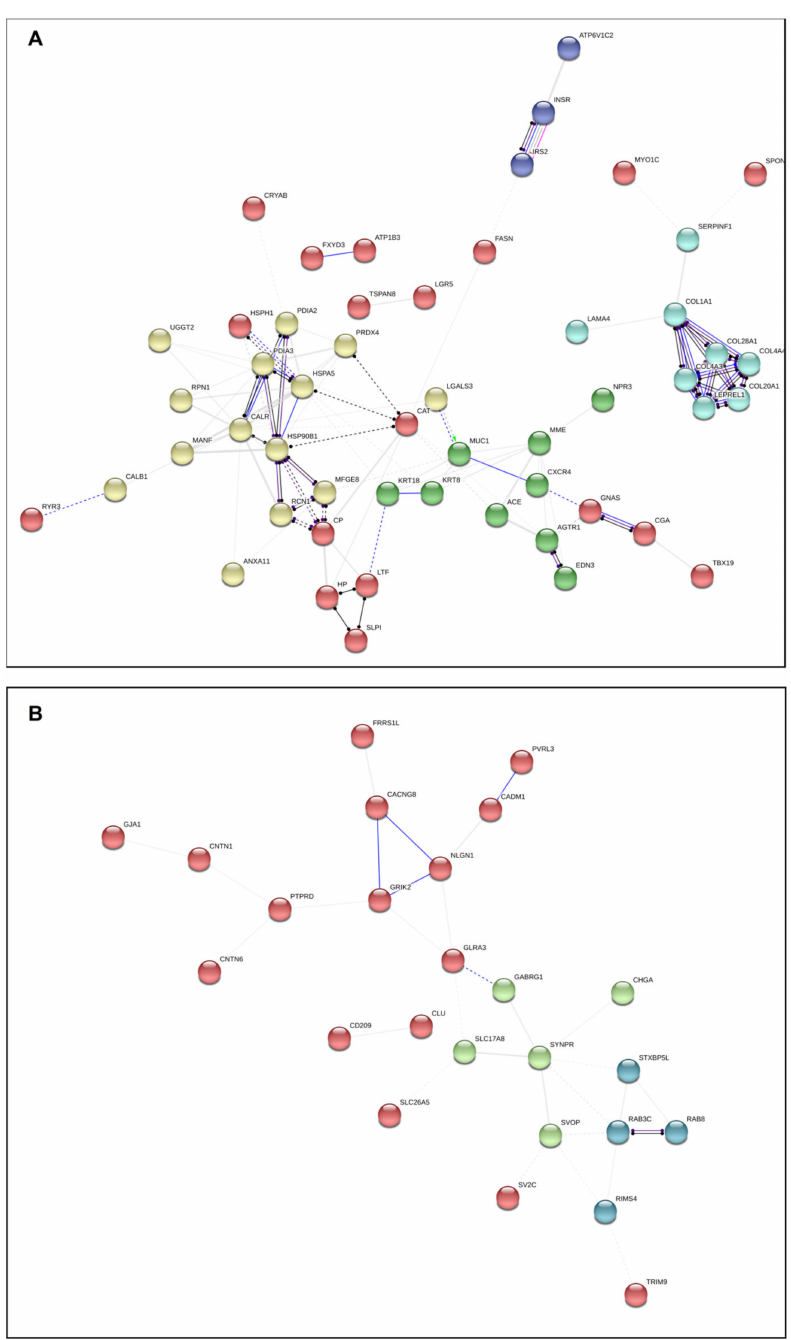
Figure 4. Network analysis presenting DEG interactions in functioning (FCA) ( A ) and silent (SCA) ( B ) corticotroph adenomas based on selected distinct biological processes and cellular components overrepresented in FCA and SCA. GO processes representative of the pituitary tumor phenotype or involved in hormone production / secretion and tumor growth were selected to be presented in the figure. For a comprehensive list of all the significant processes in the overrepresentation test and the selected ones, please see Supplementary File S1 (biological_process_SEQ, cellular_component_SEQ, GO selected_SEQ and GO matches_SEQ) and the online figure for FCA at https: // version-11-0.string- db.org / cgi / network.pl?networkId = 6sMwLJjOC4ua and for SCA at https: // version-11-0.string-db.org / cgi / network.pl?networkId = pdN7O6hmQ5G3. The color of the circles indicates the result of a K-means algorithm for identifying clusters of genes according to their interaction